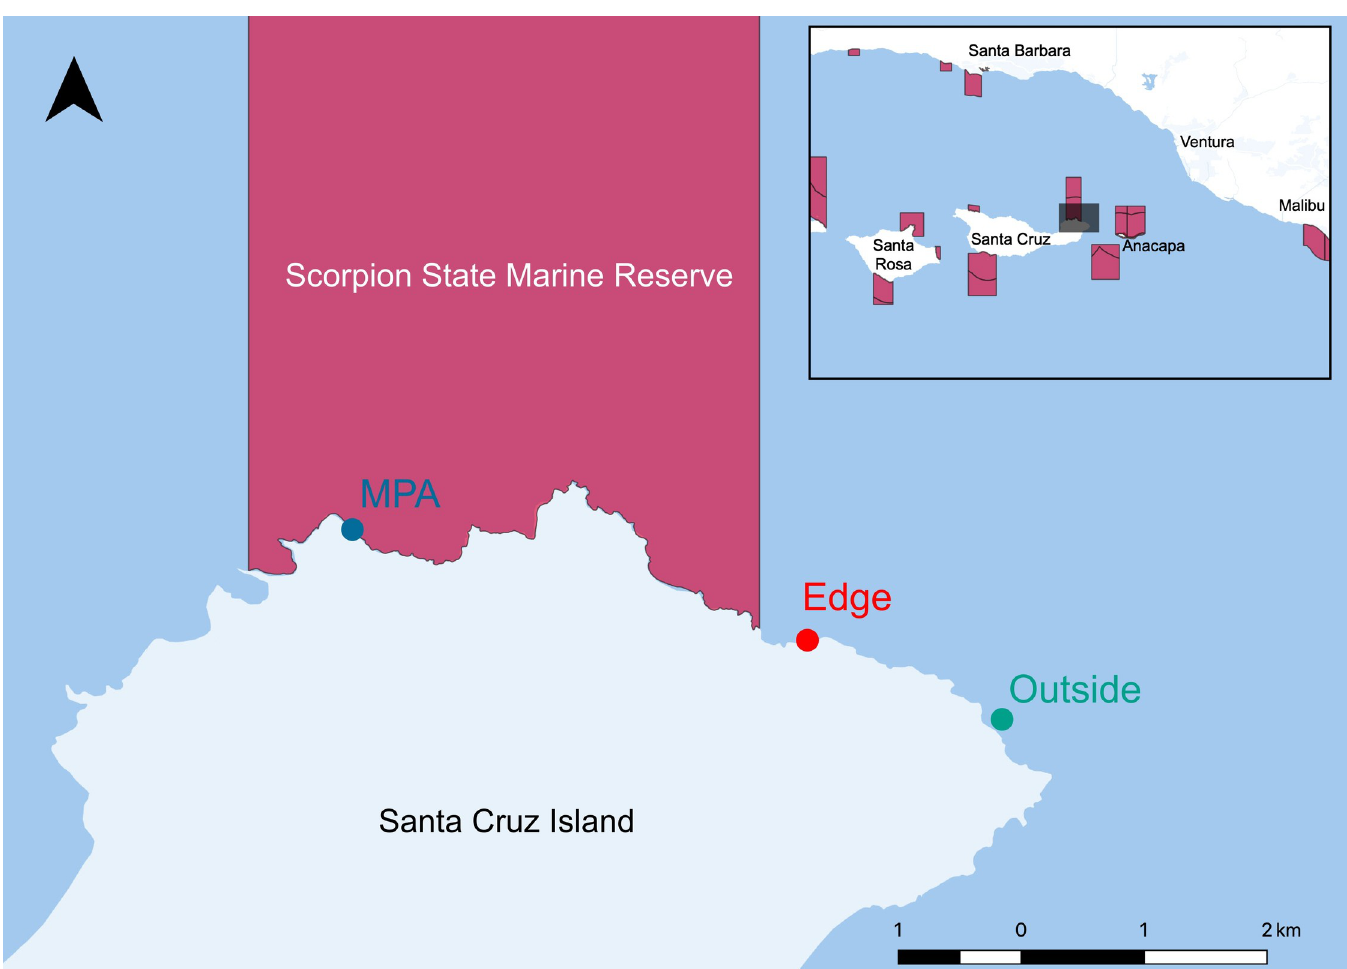
Fig 1. Map of Scorpion State Marine Reserve off Santa Cruz Island, CA, USA. The map was generated using the free and open source software QGIS version 3.0.